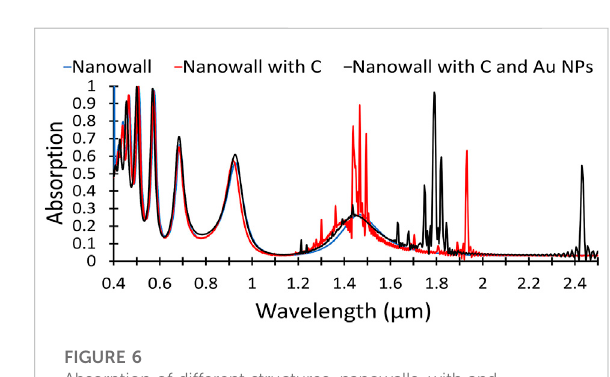
FIGURE 6 Absorption of different structures, nanowalls, with and without graphene layer, and with Au